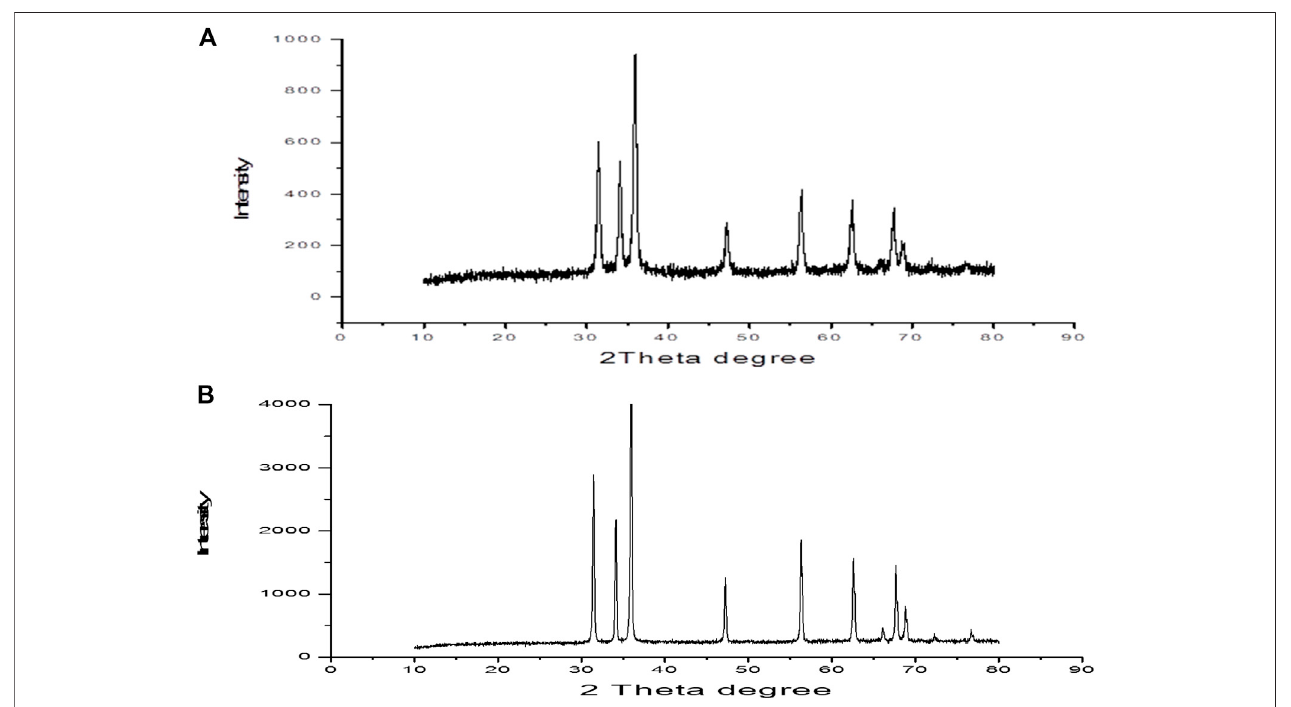
FIGURE 3 | XRD patterns of the fabricated and commercial